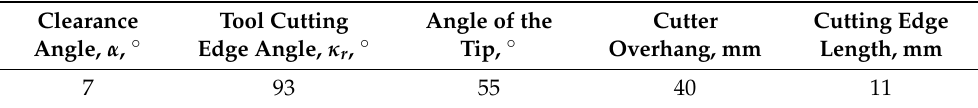
Table 1. Parameters of